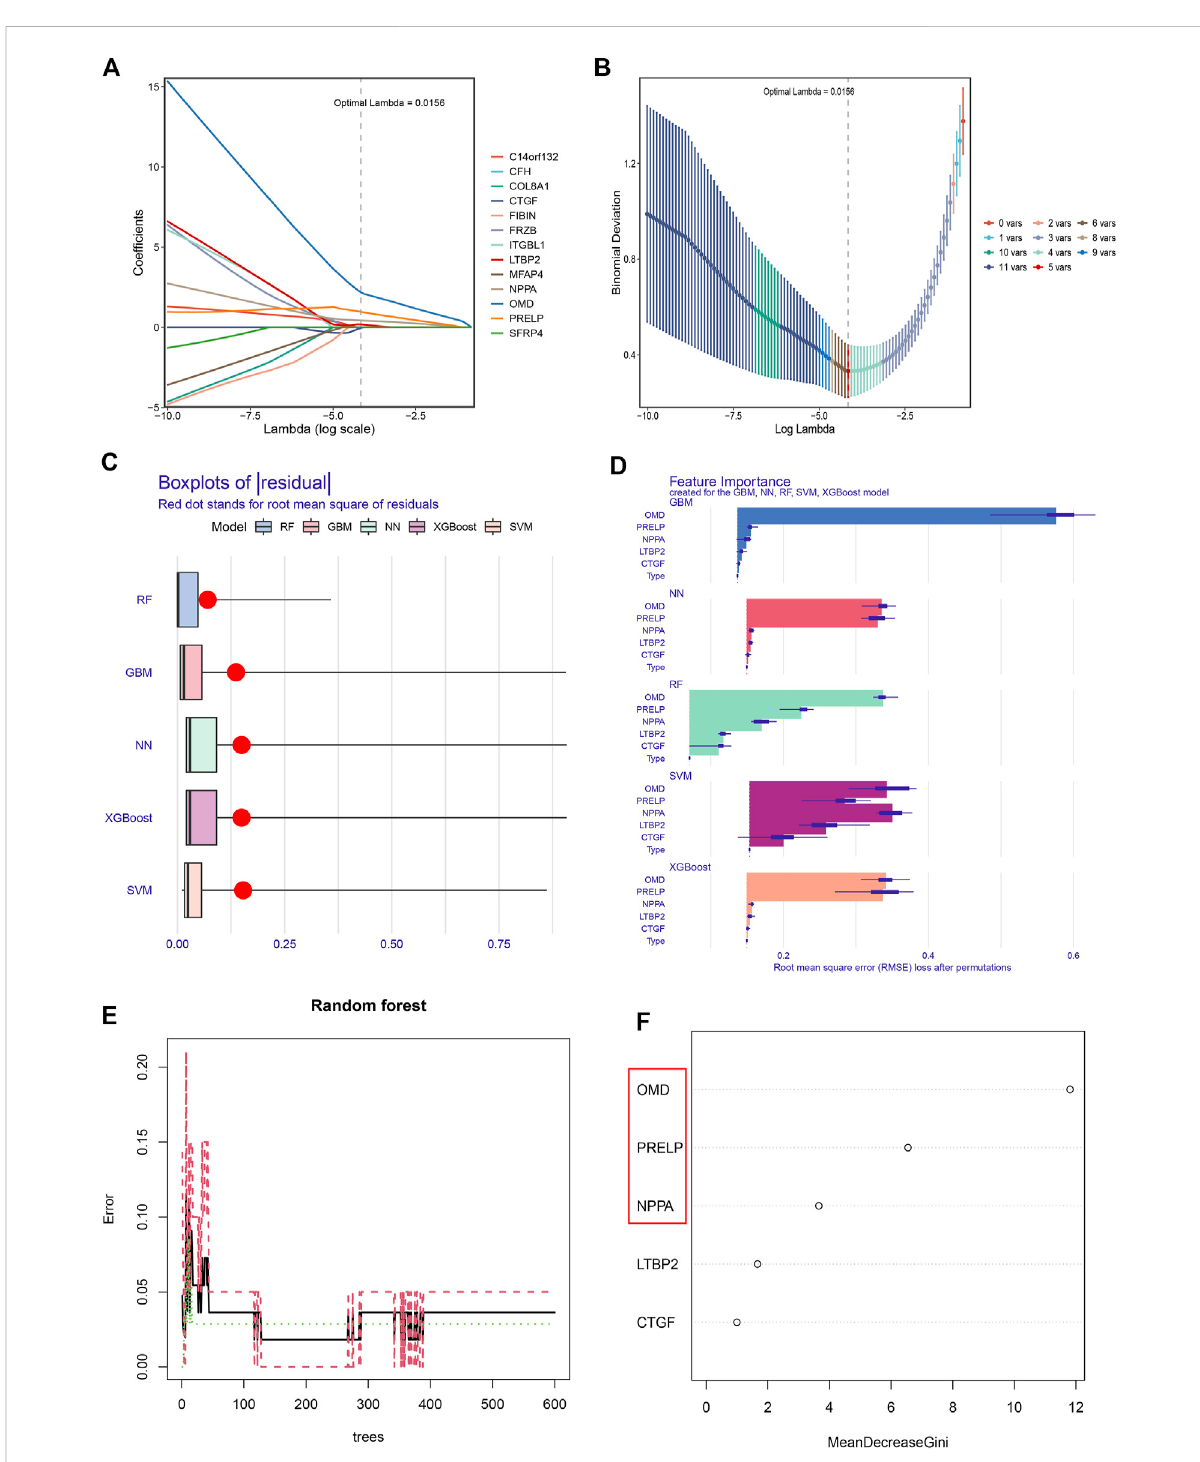
FIGURE 6 ObtainingthekeygenesforthediagnosisofDCMwithHF. (A) Thecoef fi cientsof13featuregenesshownbylog( λ ). (B) Therelationshipbetween binomialdeviationandlog( λ )by10-foldcross-validation(CV). (C) ResidualdiagramofRandomForest(RF),GradientBoostingMachine(GBM),Neural Network(NN),eXtremeGradient Boosting(XGBoost),andSupportVectorMachine (SVM)classi fi cation. (D) RootMeanSquareError(RMSE) lossafter featureremovalfrommodels. (E) TheeffectofdecisiontreenumberonCVerrorofRFclassi fi er.Green,red,andblackcurvesrepresenttheerror ofcontrol,DCM withHF, and totalgroups,respectively. (F) Themean decrease Gini coef fi cientsof genesintheRFclassi fi er.OMD,PRELP,and NPPA were the key genes with mean decrease Gini larger than